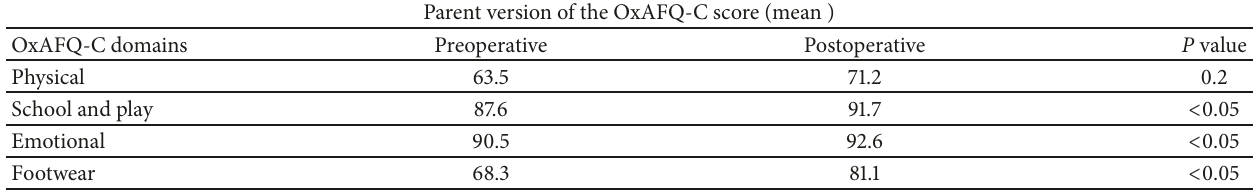
Table 3: Mean pre- and postoperative differences in the parent version of the Oxford Ankle Foot Questionnaire for Children (OxAFQ-C). Parent version of the OxAFQ-C score (mean